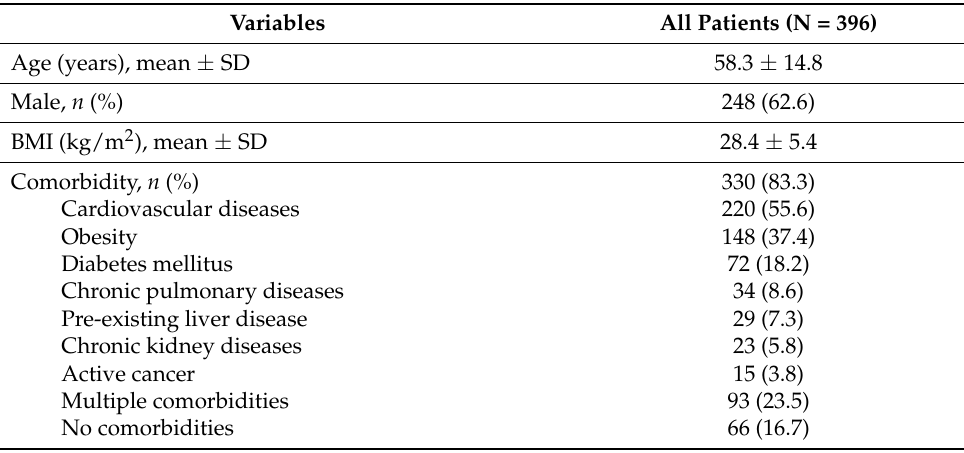
Table 1. Characteristics of the study